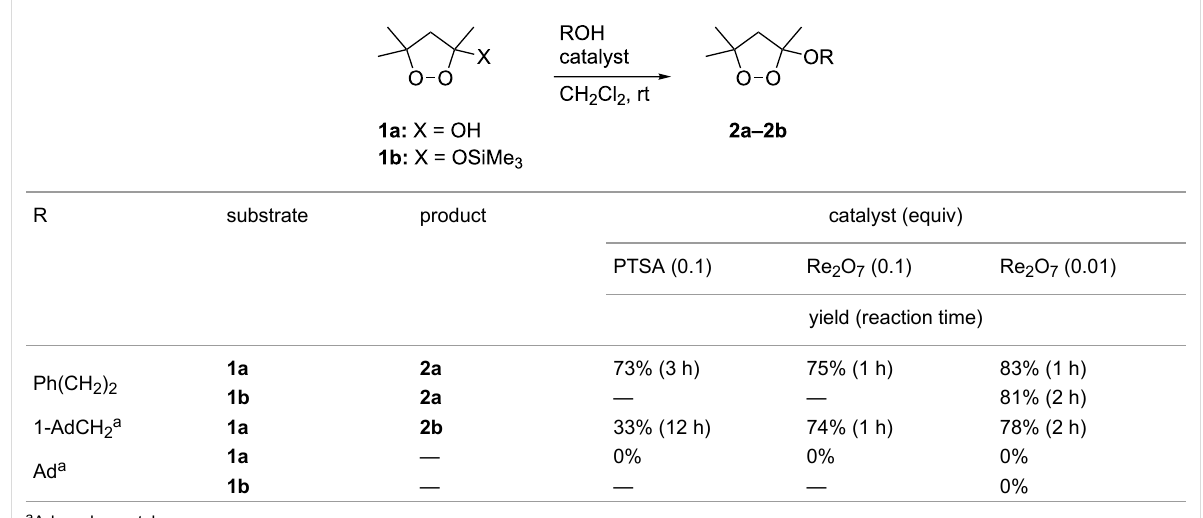
Table 1: Acetalization of hydroxy- and silyloxydioxolanes.